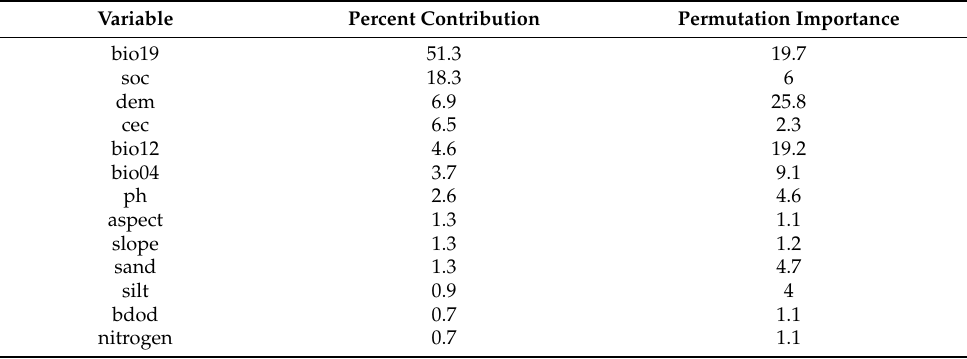
Table 3. Relative contributions (%) of environmental variables to the MaxEnt model of the genus Cedrela in Peru.